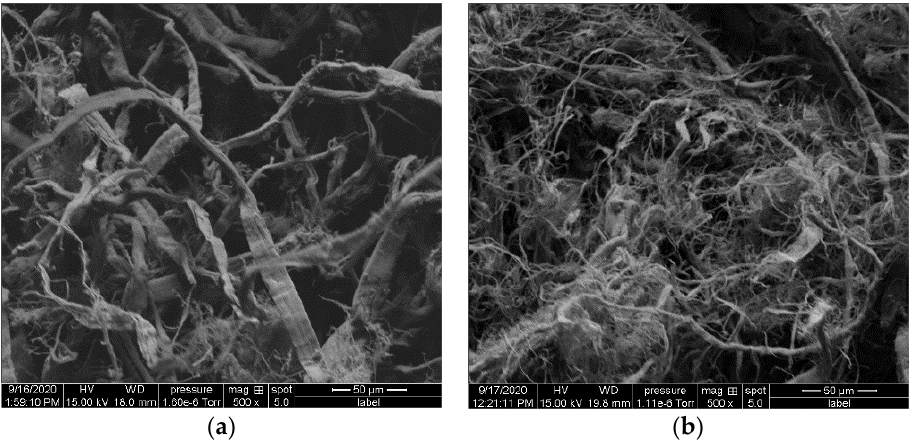
Figure 1. Micrographs of cellulose fibers ( a ) untreated, ( b ) after surfactant treatment.